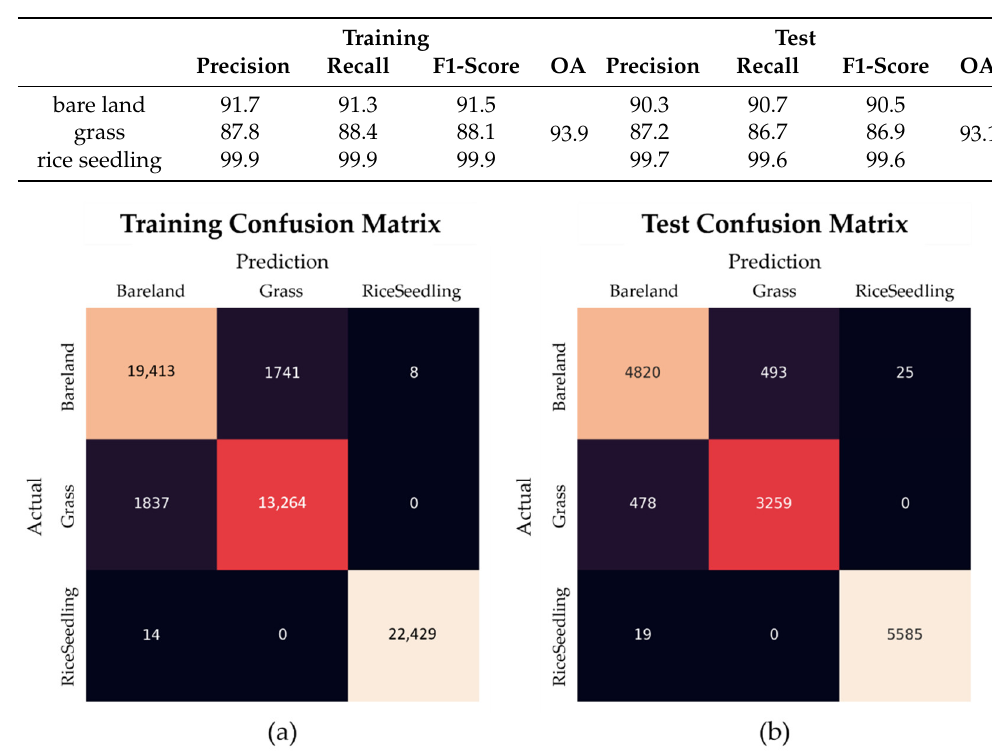
Figure 10. HOG-SVM confusion matrix of ( a ) training dataset and ( b ) test dataset. To detect rice seedlings in the paddy field images, a sliding window approach is im- plemented, where the highly overlapping tiles are firstly computed as HOG vectors and